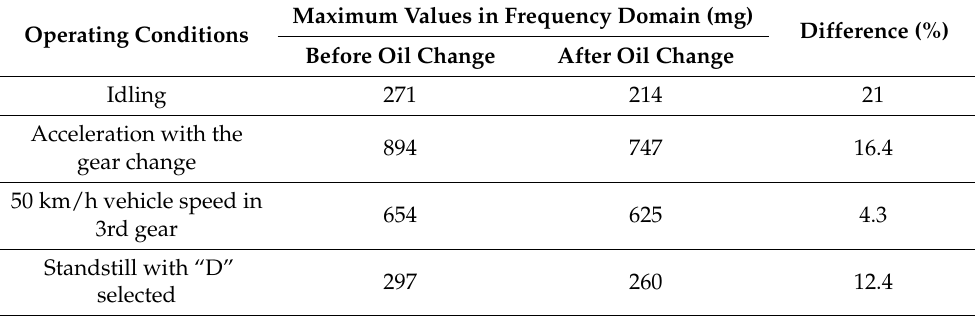
Table 2. Comparison of maximum values of frequency-based